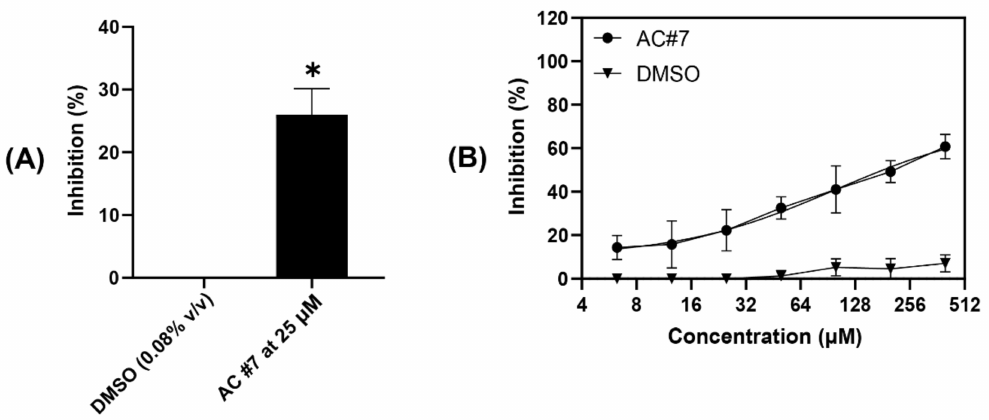
Figure 5. Quantification of the antiviral activity of AC #7. The antiviral activity of AC#7 was investi- gated by plaque reduction assay in African green monkey kidney cell line (VERO). ( A ) AC#7 demon- strated significantly high antiviral activity at a concentration of 25 µ M compared to the dimethyl sulfoxide (DMSO) control (0.08% v / v ). ( B ) AC#7 exhibited antiviral activity in a dose-dependent manner compared with the DMSO controls. The DMSO controls were tested at concentrations of 1.33%, 0.67%, 0.33%, 0.16%, 0.08%, 0.04%, and 0.02% ( v / v ), which are the concentrations at which AC#7 was dissolved in Dulbecco’s Modified Eagle Medium (DMEM) media. The plaque reduction assay was performed three times with duplicates. Means of the three experiments are plotted with standard error of the mean. One-sample t-test was applied to compare the antiviral activity of the DMSO control and AC#7 (* p <